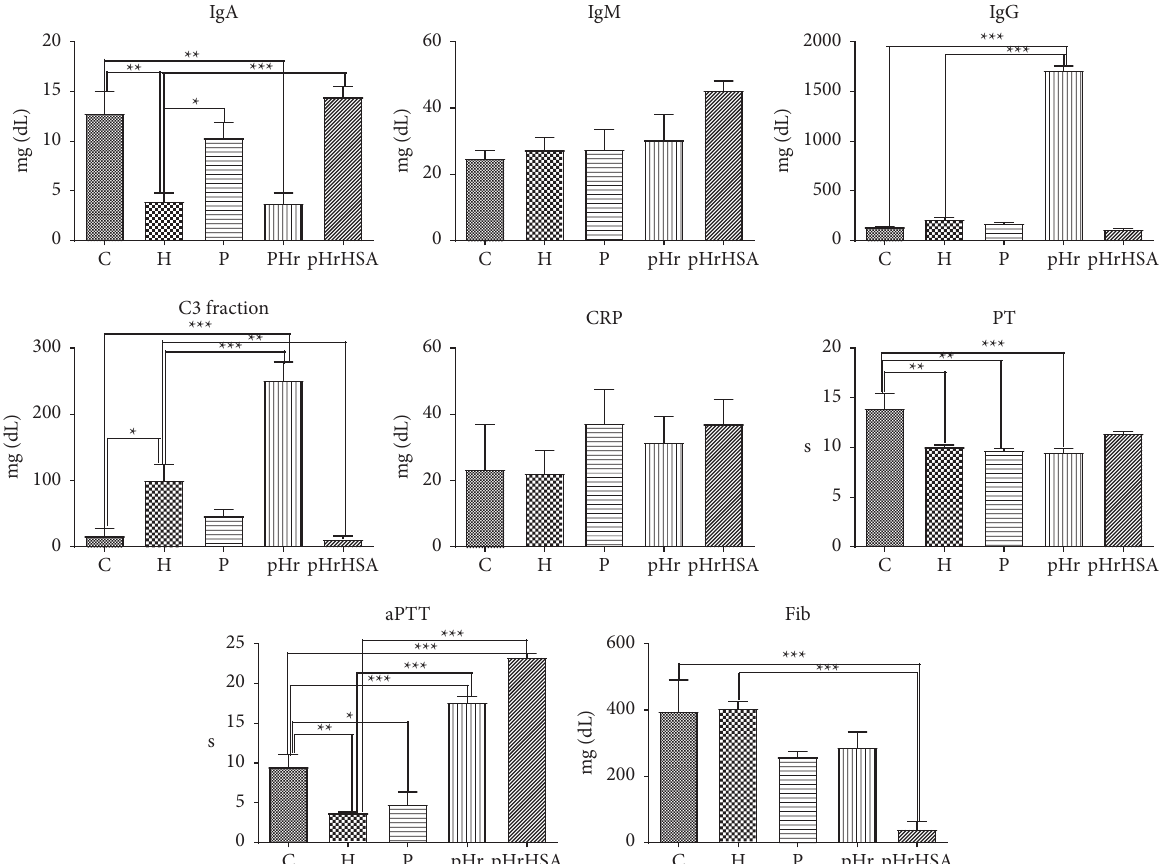
Figure 1: Immunological and clotting parameters. C � control, H � untreated hemorrhage, pHr � hemorrhage treated with poly- merized hemerythrin pHr, pHrHSA � hemorrhage treated with hemerythrin-albumin copolymer pHrHSA. Values are expressed as mean ± SD. ∗ signifcant at p < 0 . 05; ∗∗ signifcant at p < 0 . 01; ∗∗∗ signifcant at p < 0 . 001.